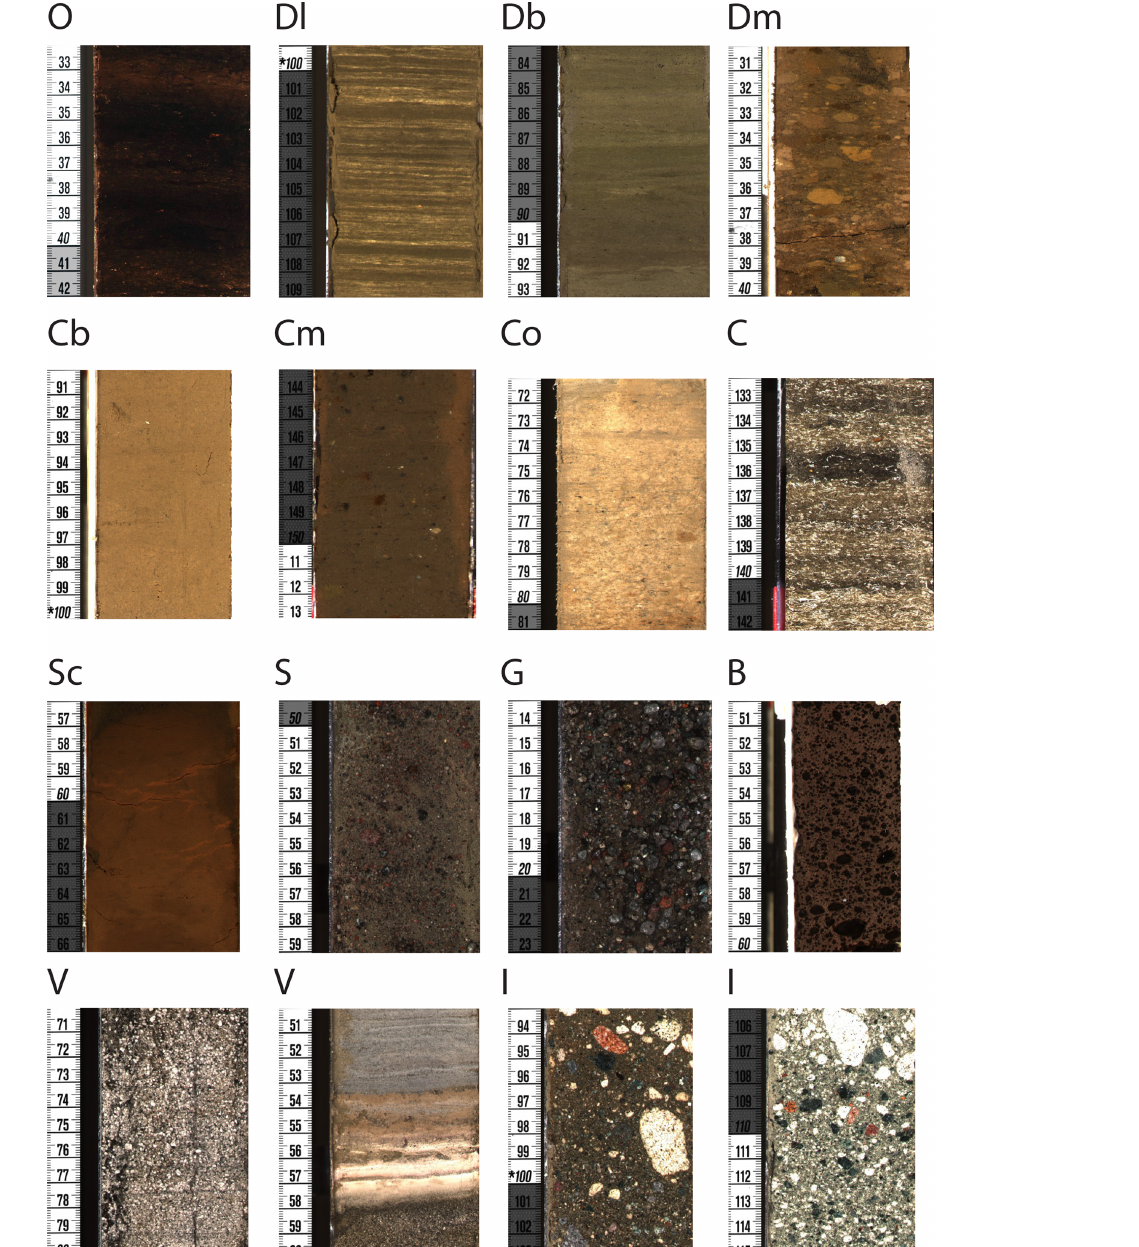
Figure 9. Representative lithologies. These include organic-rich sediments (O; MEXI-CHA16-1A-76Y-1 32–42cm) including organic- rich silty clays, sapropelic silty clays, and peat; diatomaceous silty clays, which may be laminated (Dl; MEXI-CHA16-1C-140Y-1 99– 109cm), banded (Db; MEXI-CHA16-1A-169Y-1 83–93cm), and mottled (Dm; MEXI-CHA16-1D-10C-2 30–40cm); calcareous silty clays, which may be banded (Cb; MEXI-CHA16-1D-11C-13 90–100cm), mottled (Cm; MEXI-CHA16-1B-14Y-1-A 143–153cm), or massive (Co; MEXI-CHA16-1C-174Y-1 132–142cm); gastropod-dominated coquina (C; MEXI-CHA16-1C-174Y-1 132–142cm); clastic sediments including silty clays (Sc; MEXI-CHA16- 1A-27Y-1-A 56–66cm), sand (S; MEXI-CHA16-1C-178Y-1 49–59cm), and gravel (G; MEXI- CHA16-1C-182Y-1 13–23cm); basalt (B; MEXI-CHA16-1C-231Y-1 50–60cm); volcaniclastic deposits including pyroclastic flows, lahars, and reworked volcanics (V; MEXI-CHA16-1B-181Y-1 70–80cm and MEXI-CHA16-1B-177Y-1 50–60cm); and igneous rock composed of massive cemented volcanic rocks (I; MEXI-CHA16-1A-269Y-1-A 93–103cm and MEXI-CHA16-1A-271Y-1-A 105–115cm).